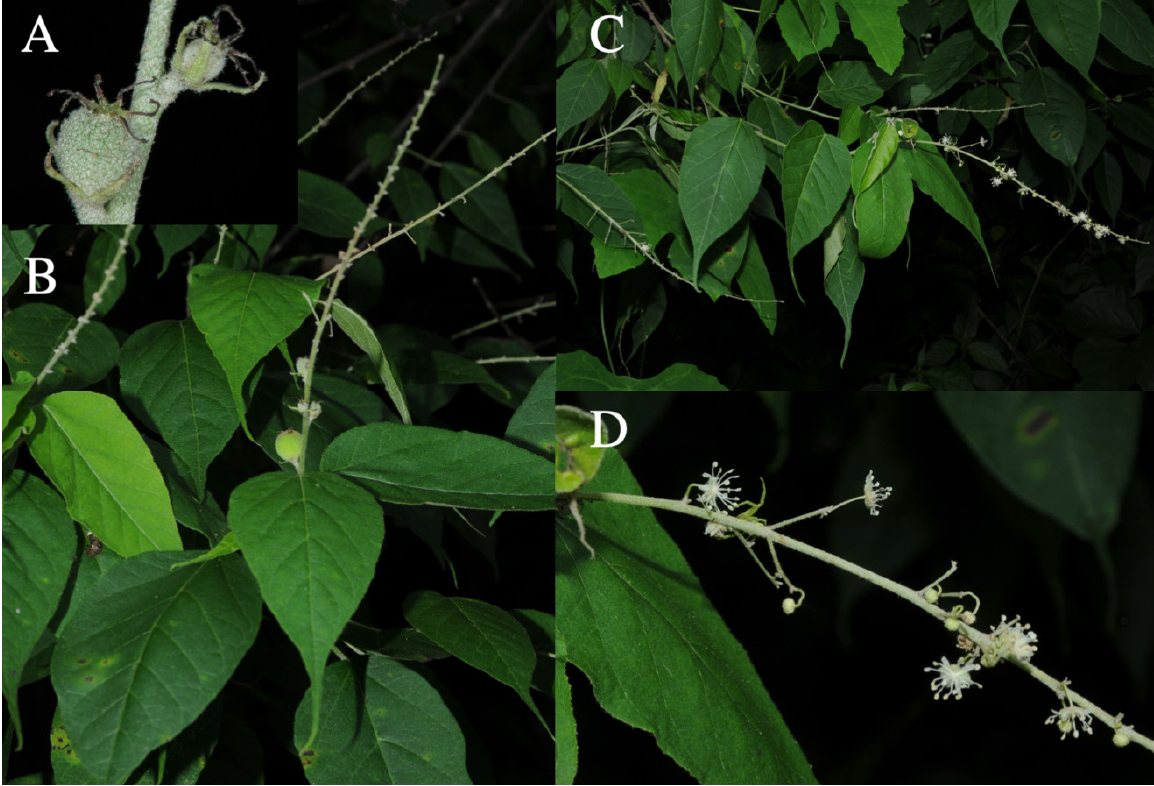
Figure A11. Croton roxanae. ( A ) Pistillate flowers. ( B , C ) Flowering branches. ( D ) Staminate portion of an